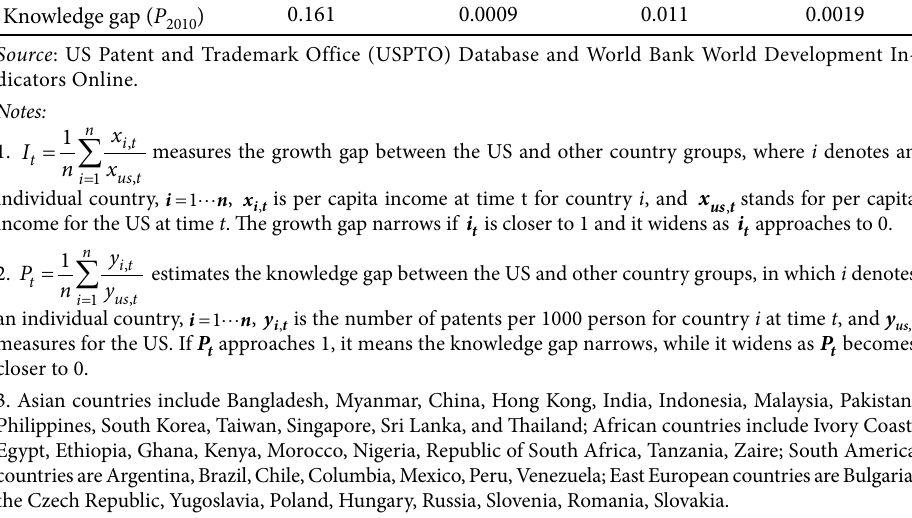
Table 1. Growth and knowledge gaps (2010) Asia Africa East Europe South America Growth gap ( I 2010 ) 0.230 0.050 0.251 0.201 Knowledge gap ( P 2010 ) 0.161 0.0009 0.011